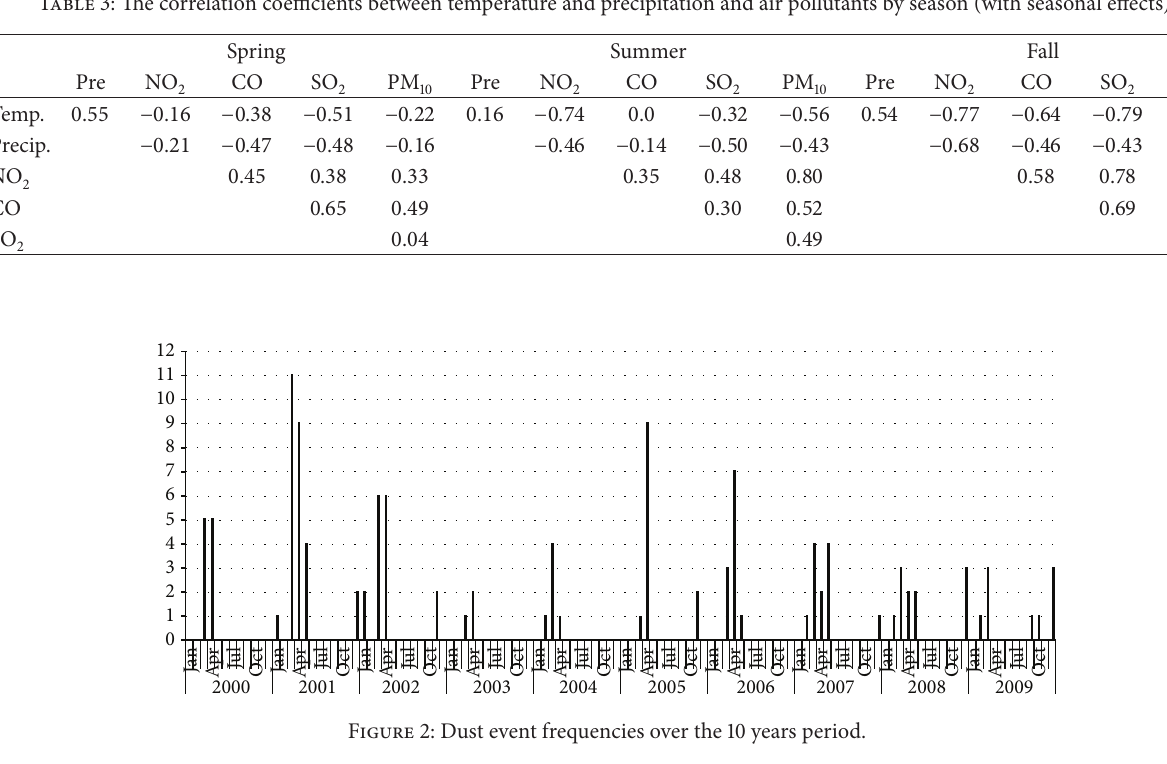
Table 3: The correlation coefficients between temperature and precipitation and air pollutants by season (with seasonal effects).